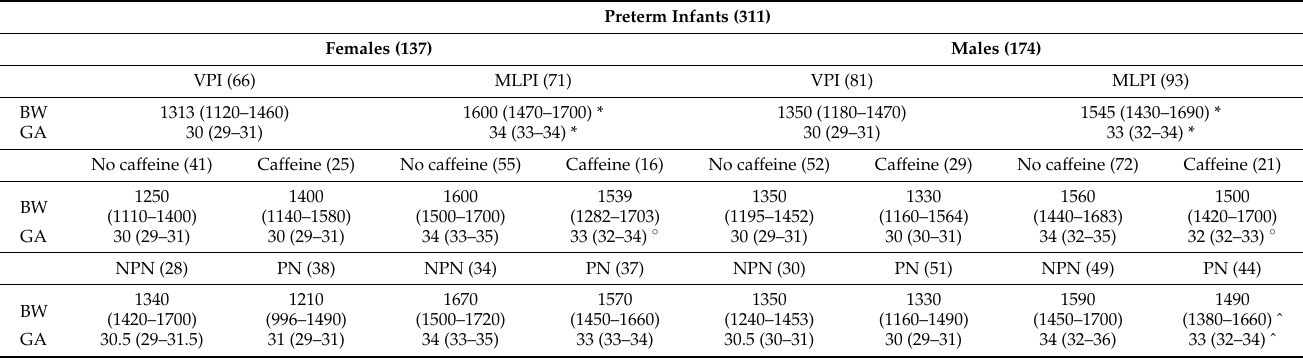
Table 1. Population stratification according to sex, gestational age (GA) (weeks), body weight (BW) (g) and caffeine treatment.